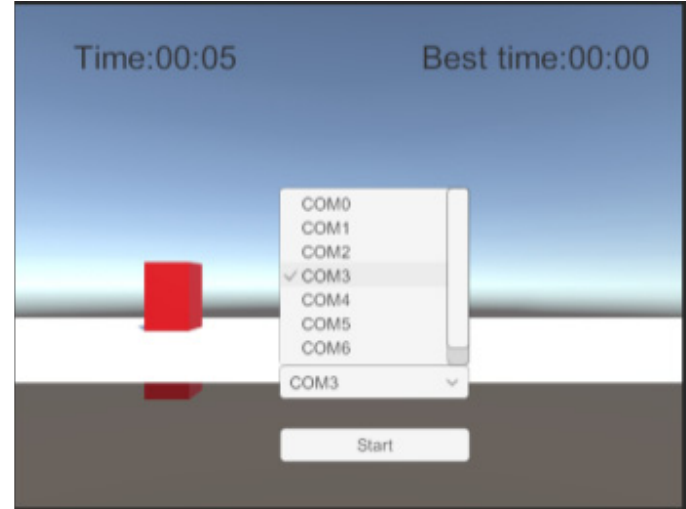
Figure 15. Game setting.